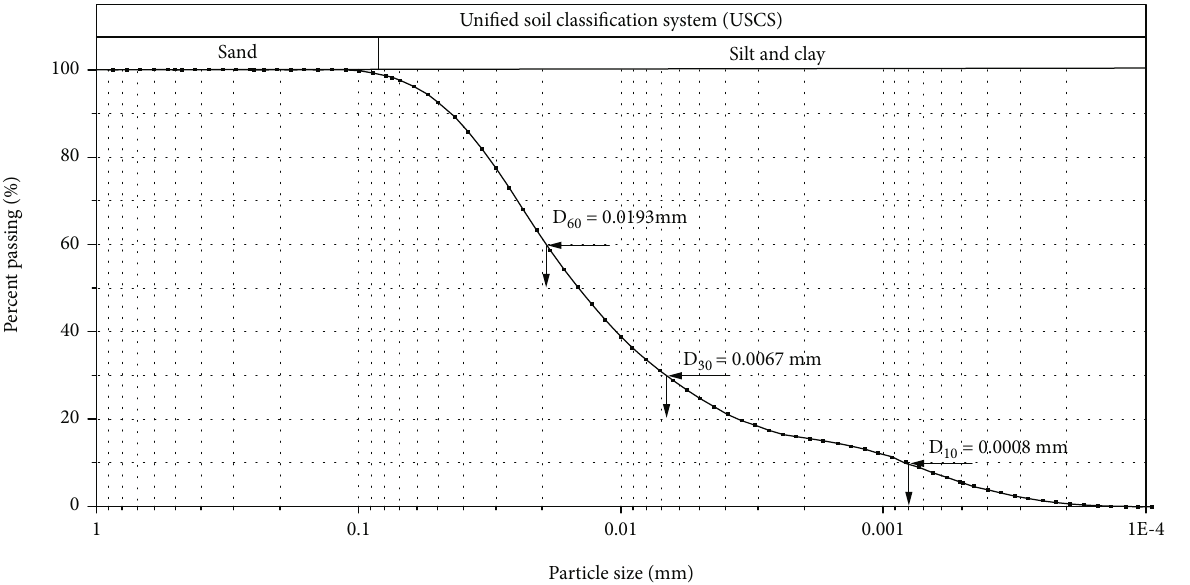
Figure 2: Particle size distributions of samples ( D on the cumulative particle size distribution curve, respectively).